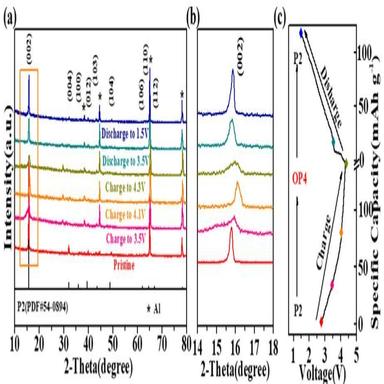
(a, b) Ex situ XRD patterns and (c) the corresponding specific capacity vs. voltage profiles for the walnut-shell-like NaNCMA-3 sample during the first charge/discharge at a current rate of 0.1C between 1.5 and 4.3 V.